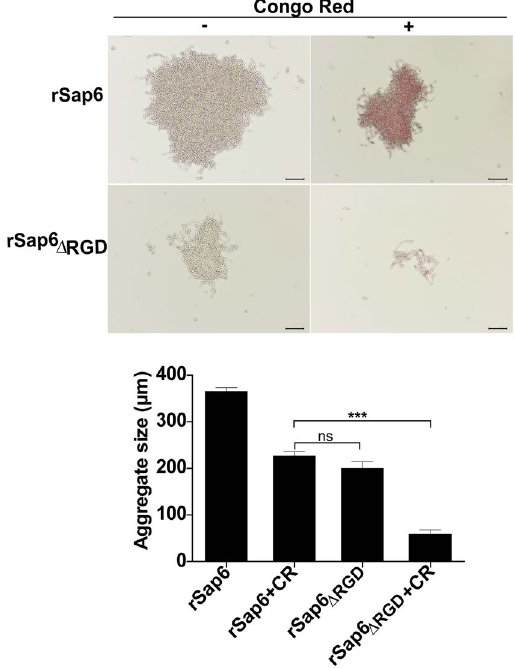
Figure 4. Amyloid regions and RGD binding sites in Sap6 both contribute to self-aggregation. Geminated C . albicans cells were incubated in the presence of Congo red (30 µ M) along with rSap6 or rSap6 Δ RGD (10 µ M) to allow Congo red binding to disrupt amyloid structure needed for autoaggregation. Average aggregate size was determined from 20 independent fields at 10X magnification using ImageJ software. Congo red significantly (P ≤ 0.01) decreased rSap6 aggregate size by nearly 45%, showing that amyloid structures account for nearly half of autoaggregation. Another 45% of aggregation was due to RGD sites as shown by the 90% reduction in aggregate size of rSap6 Δ RGD in the presence of Congo red. A small (10%) proportion of aggregation is independent of either amyloid regions or RGD. Mean ± SD of three independent experiments performed in triplicate are